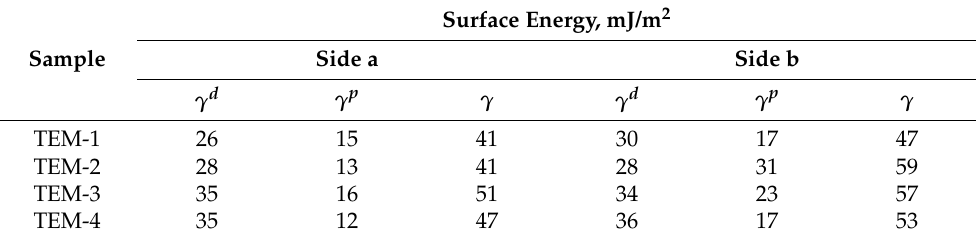
Table 3. The surface energy of the membranes.